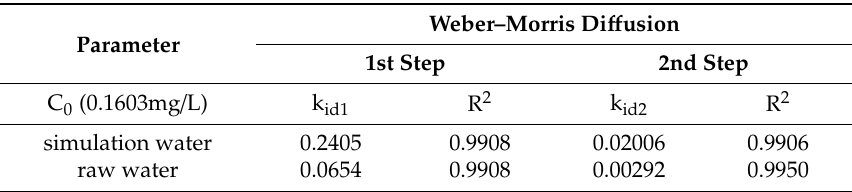
Table 3. Rate constants for the adsorption kinetic model of Mo(VI) in simulation water (SW) and raw water (RW) on NZVI / AC.